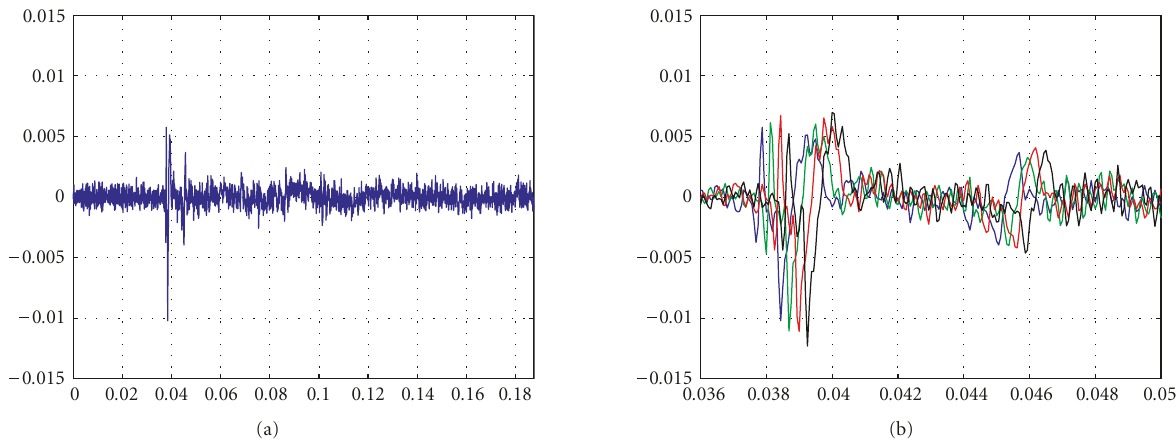
Figure 10: The measured impulse response in a real room between source position 1 and sensor 1 (a) and the measured impulse response in a real room between source position 1 and the 4 sensors of the microphone array